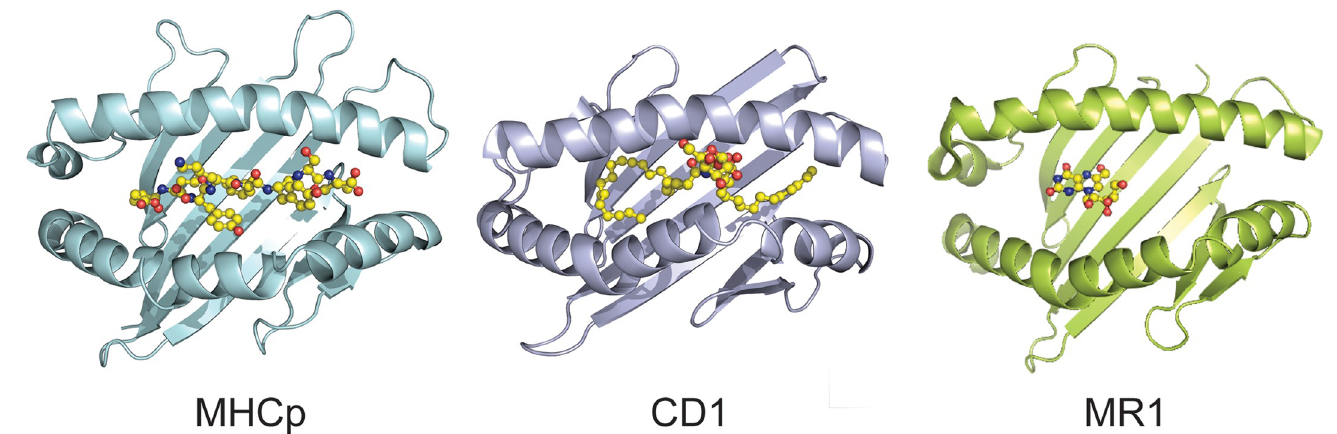
Fig 2. The MHC fold has evolved to present repertoires of chemically diverse antigens. Representative structures of the platform domains of classical MHC presentation of peptide antigens (H2-Kb with DEV8 peptide, PDB ID: 2CKB, on left [67]); CD1 presentation of lipid antigens (CD1d with α -Galactosylceramide,